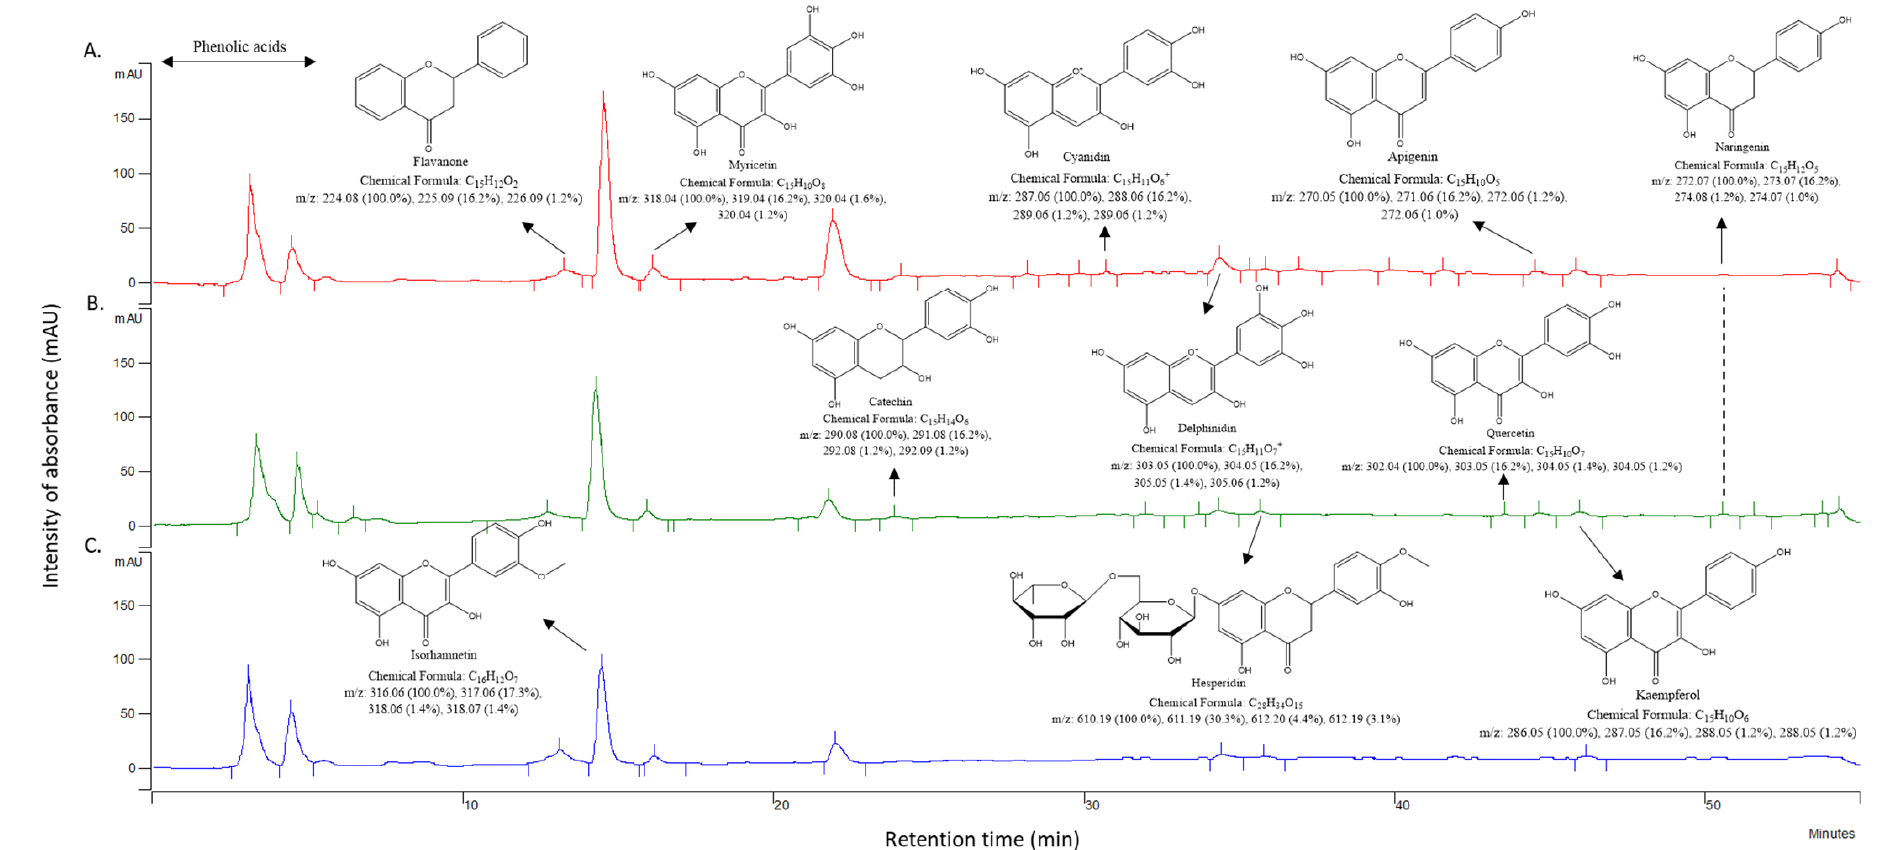
Figure 5. HPLC-UV spectra of ethanolic extracts of Agave lechuguilla by-product harvested from: ( A ) Matehuala, ( B ) Cosme, and ( C ) Tuxtepec, and lyophilized. Compound structure, name, and MS data were added using ChemDraw Professional (version 15.0) based on the result of Workstation Star Toolbar spectra analyses (Tables 1 and 2) and analytical standards curve. Table 2 . Qualitative profile of flavonoid compounds in guishe ethanolic extract. Experimental m/z and major fragments were obtained by HPLC-MS analysis in negative polarity ([M-H] - ).